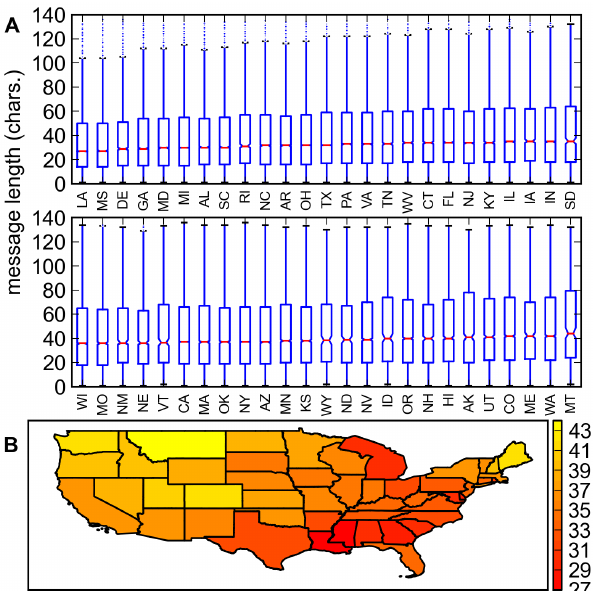
Figure 6. Utterance lengths across US states. A. Box plot of the utterance length distribution of each US state sorted by increasing median utterance length. The notches were estimated using 10,000 bootstrap repetitions but the resulting bootstrapped median values are the same as the empirical median values B. Contiguous US states colored with the bootstrapped median utterance